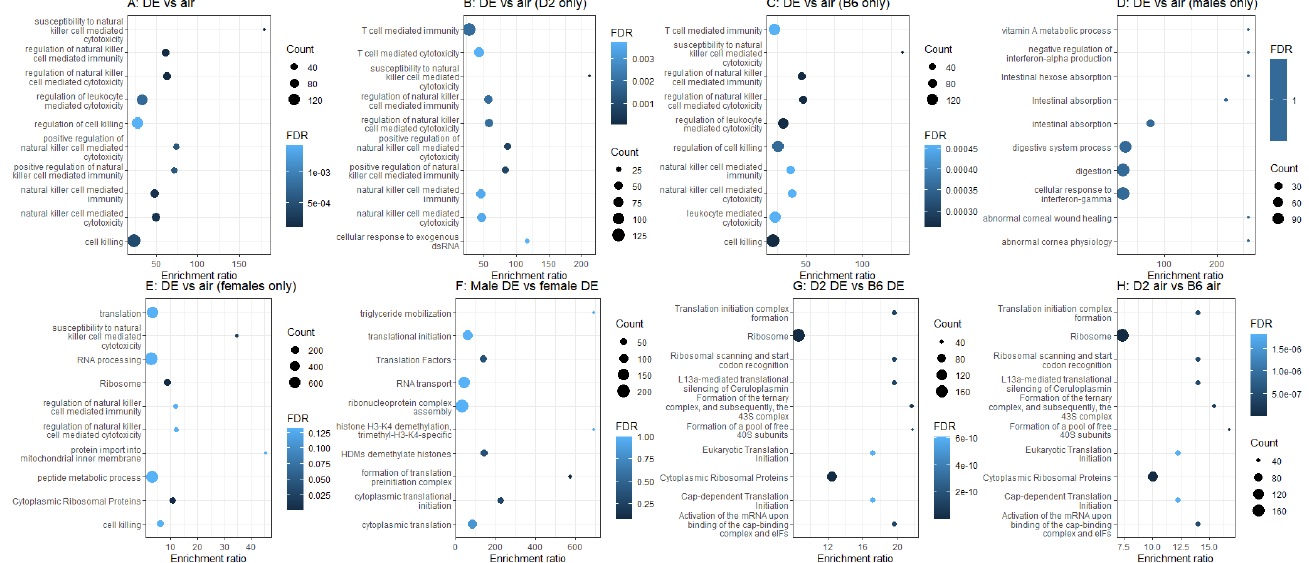
Figure 4. Top 10 most significantly enriched annotations for each pairwise comparison between groups. Comparisons are between diesel exposed (DE) and control (air), DBA/2J (D2) and C57BL/6J (B6), and sex (male vs. female). The x ‐ axis represents the enriched ratio and the y ‐ axis represents enriched pathways/terms. The size of each dot represents the number of genes and the color indicates the FDR. The enriched ratio is defined as the number of observed genes divided by the number of expected genes from the annotation category in the gene list.